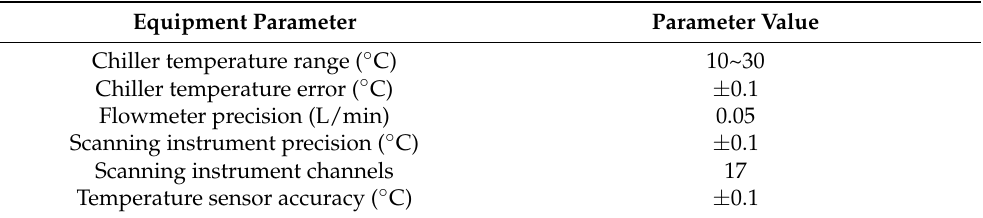
Figure 8. Sensor placement position of the test platform.